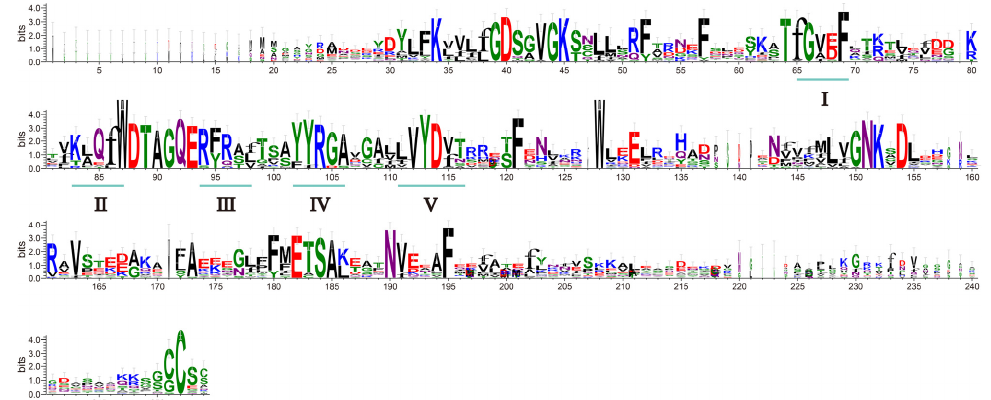
Figure 5. Web logo representing the PSPG-box motif of MaRabs . The five lines ( I – V ) represent conserved PSPG-box motifs shared by the Rab proteins. The logo is mainly composed of symbol stacks. Each location in the sequence has a stack. The overall stack height indicates the sequence’s conservation at that place, whereas the symbol height inside the stack indicates the relative abundance of each amino acid at that location.